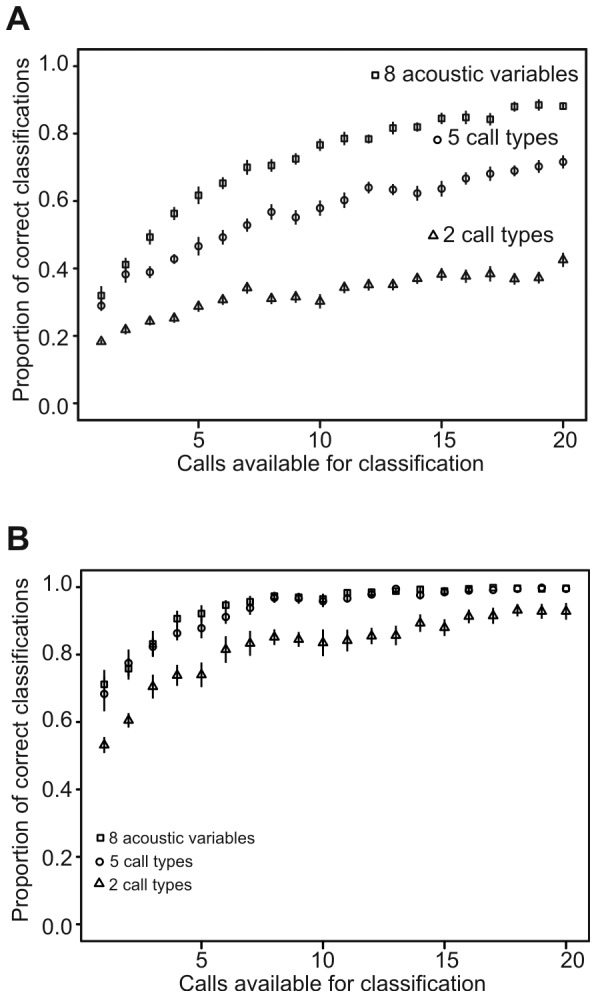
Simulation of average overall classification success of calls to situations depending on number of calls available for classification.A. Classification into one of the 11 situations; B. classification in the gross biological type of situation (life threat/nursing/other). The situation of the piglet was identified from the call(s) based either on 8 acoustic variables (square) or on types of the calls – either 2 call types (triangle) or 5 call types (circle). Mean proportion of correct classifications and 95% Confidence Interval for the mean from 20 repeated simulations are displayed.